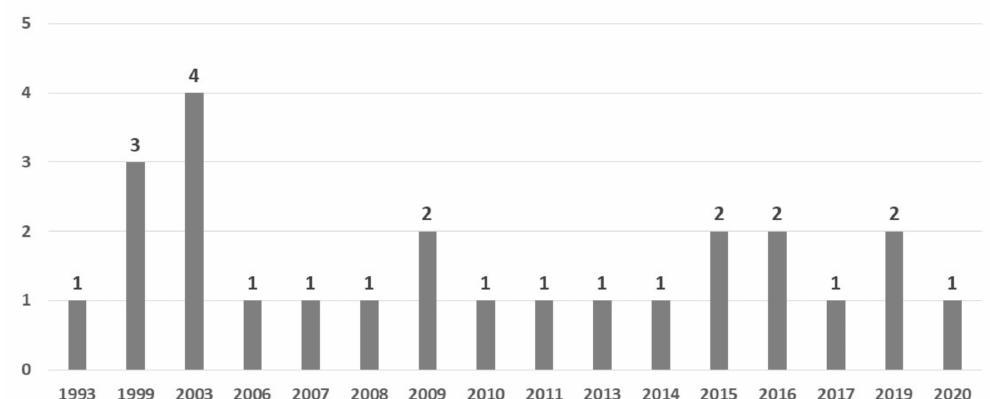
Figure 3. The number of studies included in the scoping review according to the year of publication.